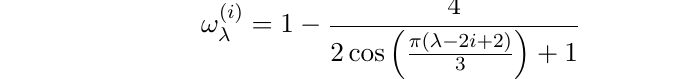
JJJ (cid:31) (cid:30)